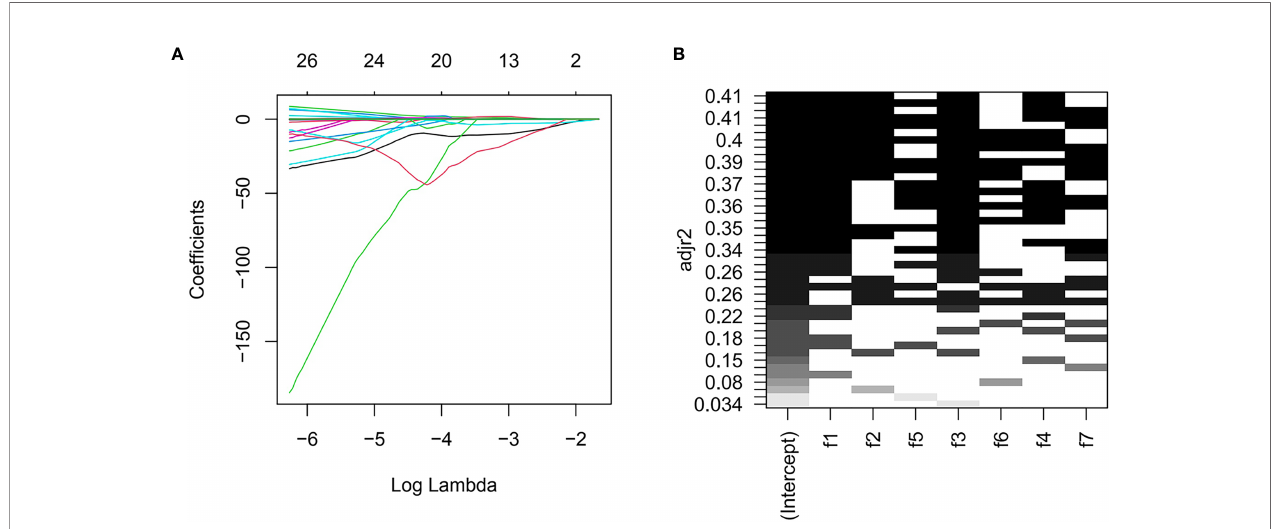
FIGURE 2 | Features selection for PET/CT-Rad Model. (A) LASSO regression coef fi cient of the selected features could change with log (lambda). (B) further all- subsets regression based on seven features fi ltered by LASSO. adjr2, adjusted R square; f1, CT_glcm_InverseVariance; f2, CT_glrlm_LowGrayLevelRunEmphasis; f3,